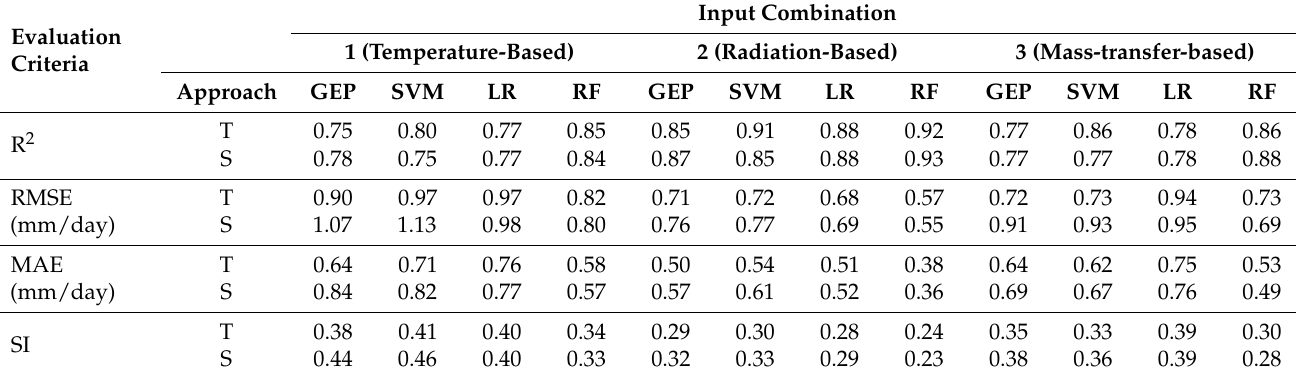
Table 3. Global average performance indicators of the gene expression programming (GEP), support vector machine (SVM), multiple linear regression (LR), and random forest (RF) methods for three input combinations of local (T) and spatial (S) approaches. Evaluation